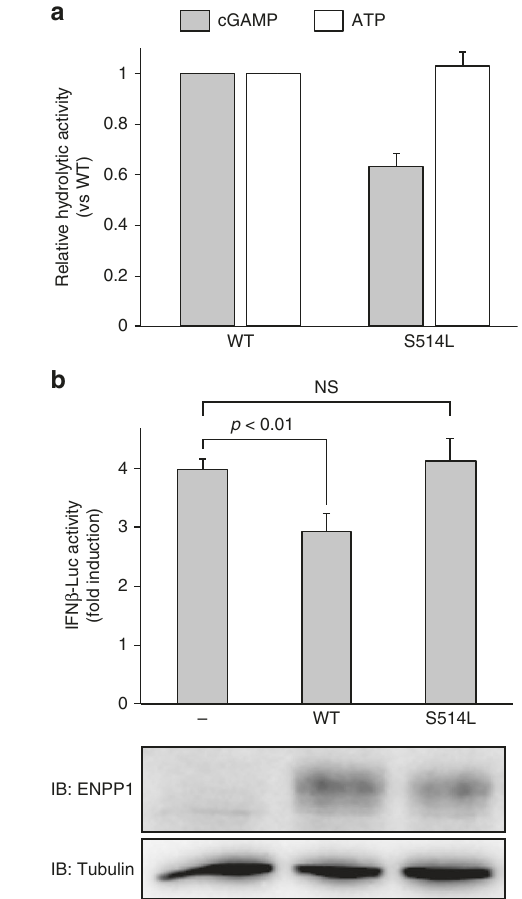
Table 1 Data collection and re fi nement statistics